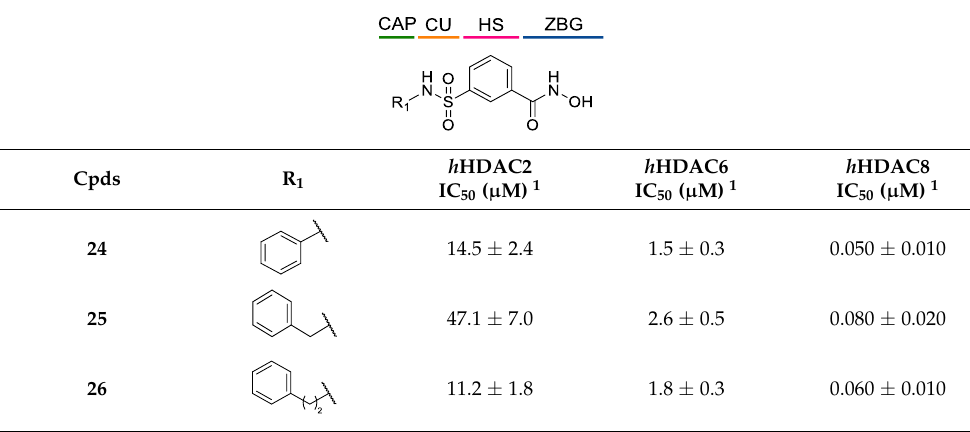
Table 4. General structure and IC 50 values of 24 , 25 , and 26 [34].